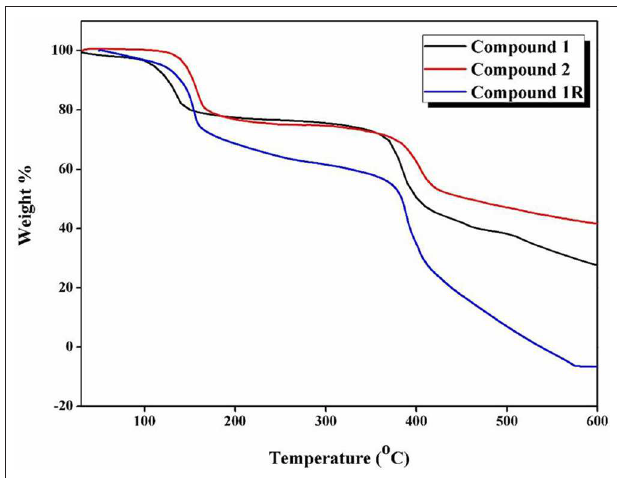
FIGURE 5 | Thermogravimetric curves of the compounds 1 , 2 , and 1R